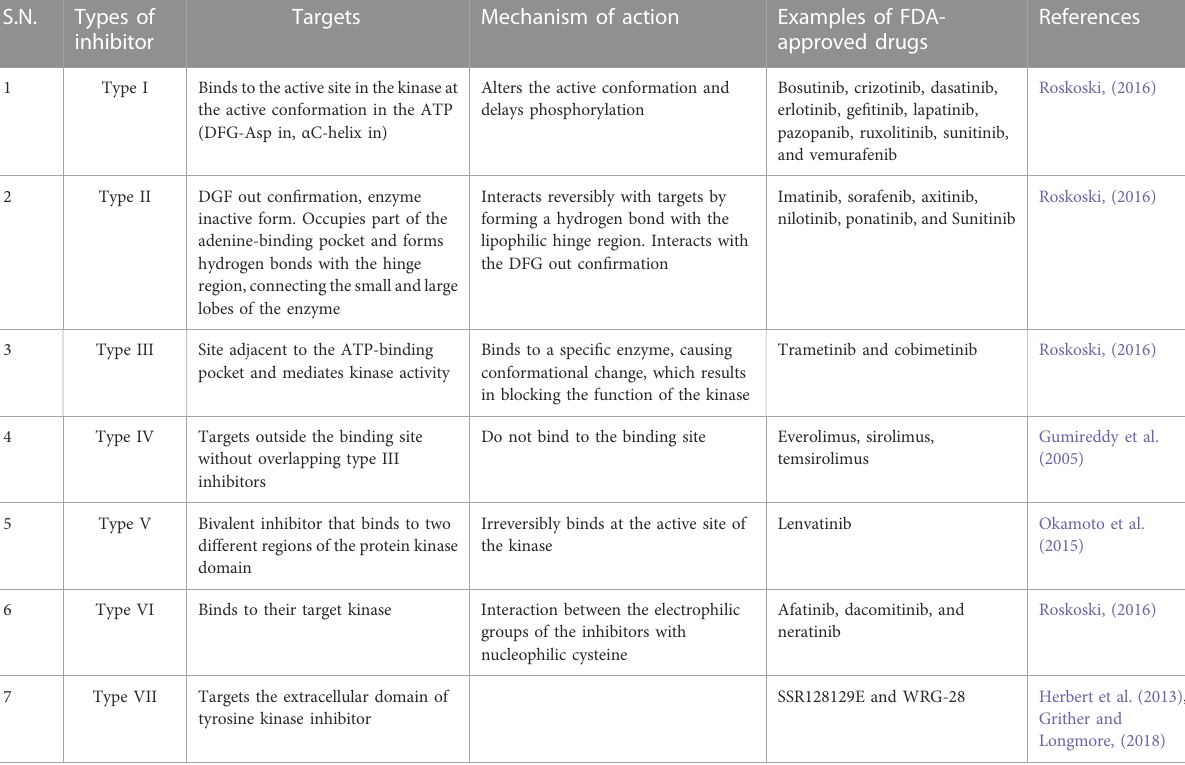
TABLE 4 Targets and mechanism of action of different types of FDA-approved tyrosine kinase inhibitors.